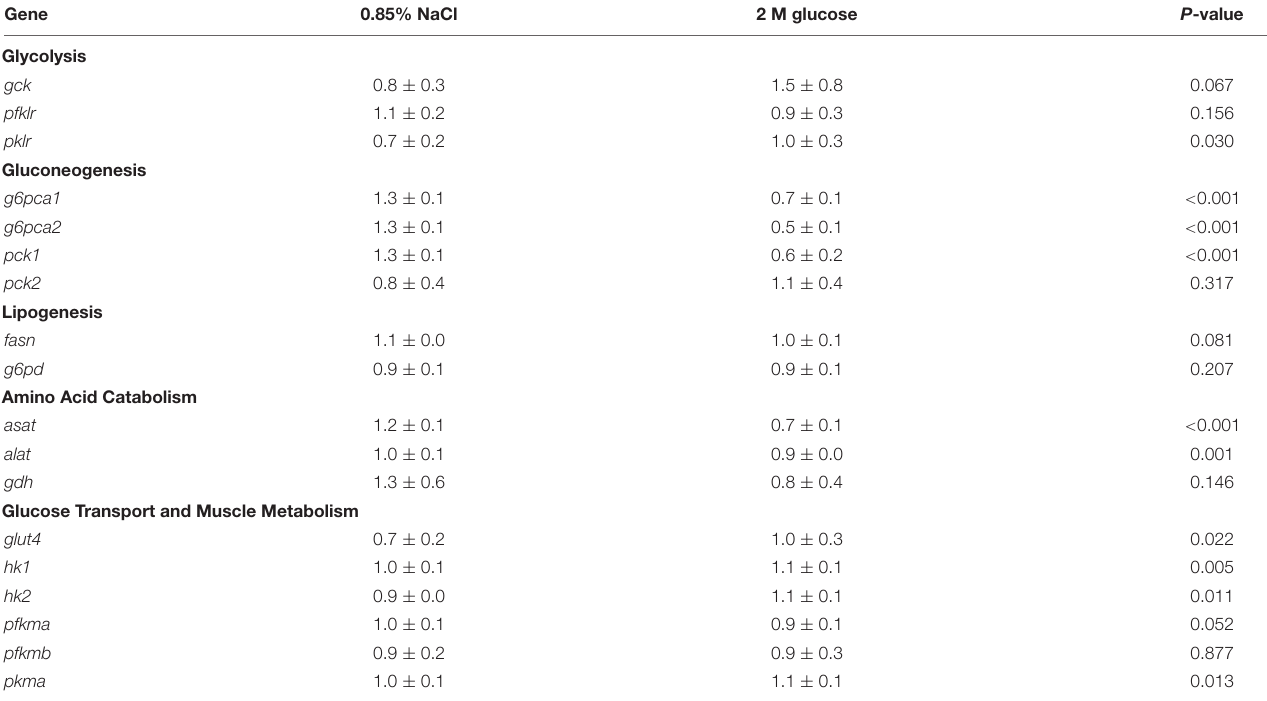
TABLE 2 | mRNA levels of genes involved in carbohydrate metabolism in the whole body of Nile tilapia (at 1 wpi) that were microinjected with either 0.85% NaCl or 2 M glucose (mean ± SD, n = 6). Gene 0.85% NaCl 2 M glucose P